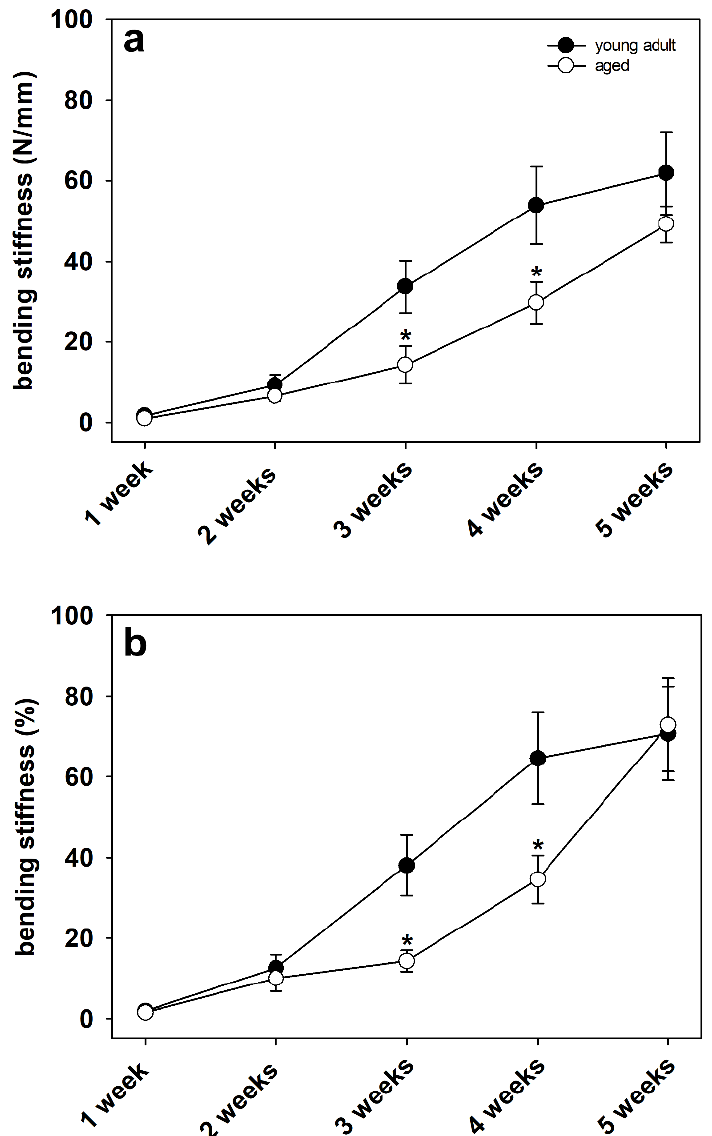
Figure 4. ( a ) Analysis of the bending stiffness (N/mm) of the fractured femora at 1, 2, 3, 4 and 5 weeks after fracture in young adult (black circles, n = 10) and aged (white circles, n = 10) CD-1 mice (Mann–Whitney U test used at 1, 2 and 5 weeks, Student’s t -test used at 3 and 4 weeks). ( b ) Analysis of the bending stiffness (%) of fractured femora in relation to the corresponding unfractured contralateral femora at 1, 2, 3, 4 and 5 weeks after fracture in young adult (black circles, n = 10) and aged (white circles, n = 10) CD-1 mice (Mann–Whitney U test used at 1, 2, 3 and 5 weeks, Student’s t -test used at 4 weeks). Means ± SEM; * p < 0.05 vs. young adult.